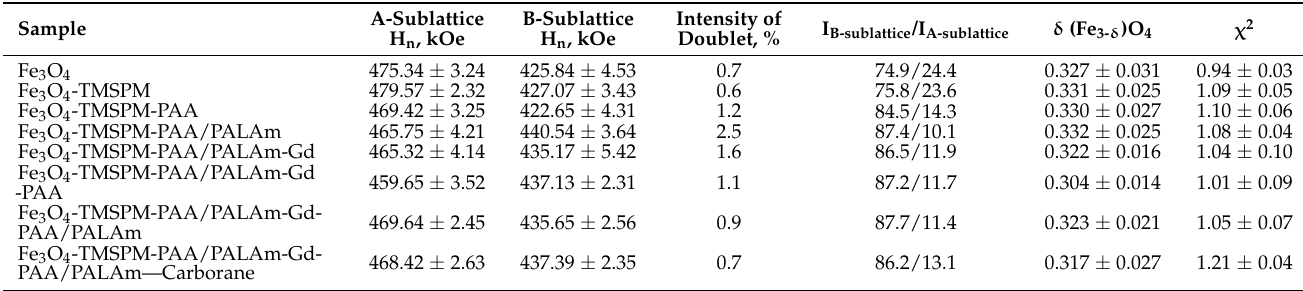
Table 3. Experimental values of the Mössbauer spectra of Fe 3 O 4 nanoparticles at different stages of modification and carboranes immobilization.